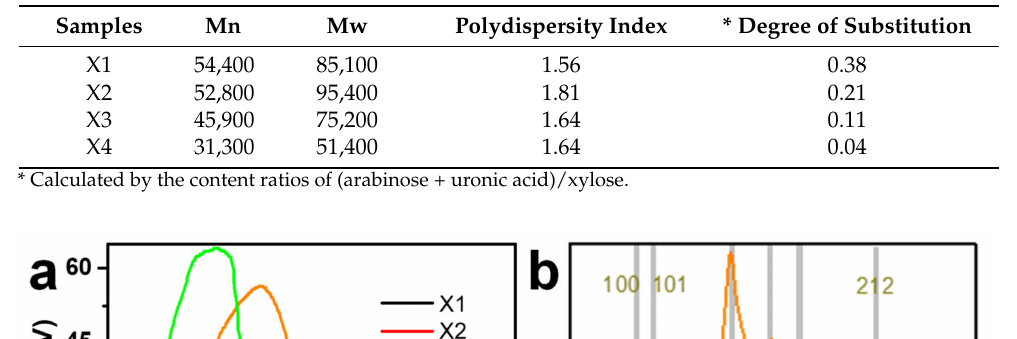
Table 3. Molecular structures of separated xylan fractions.